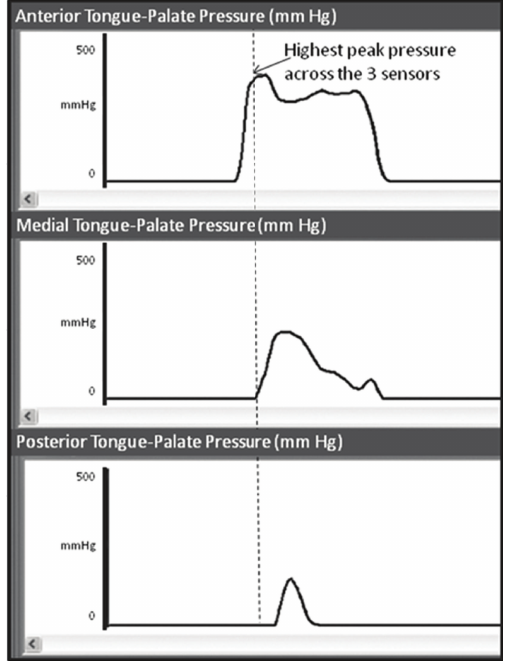
Figure 1: Illustration of tongue-palate pressure waveforms on the KayPentax Digital Swallow Workstation. The highest peak pressure (in mmHg) across the anterior, medial, and posterior sensors was used as the value of peak pressure for each